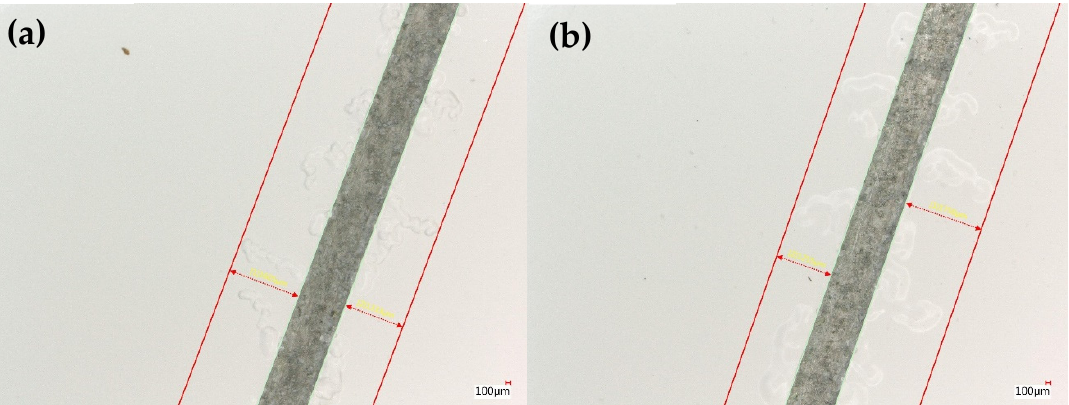
Figure 15. Comparison of filament appearance during FFT for ( a ) samples anodised at higher temperature and ( b ) samples anodised at lower temperatures.